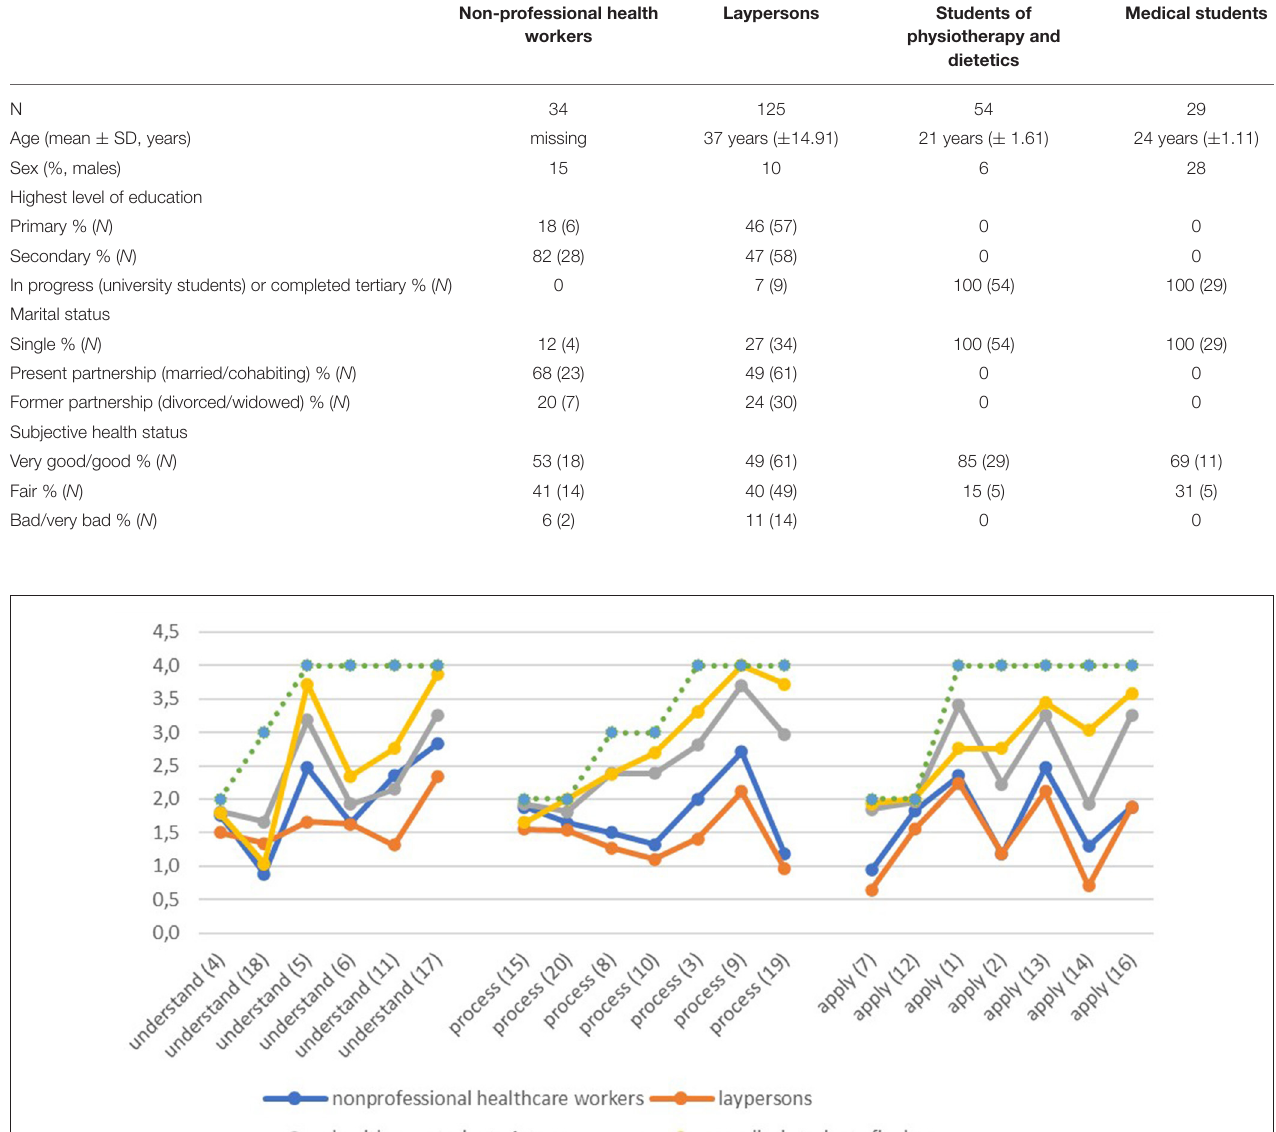
can be converted to the Flesch-Kincaid Index which specifies the grade level of the